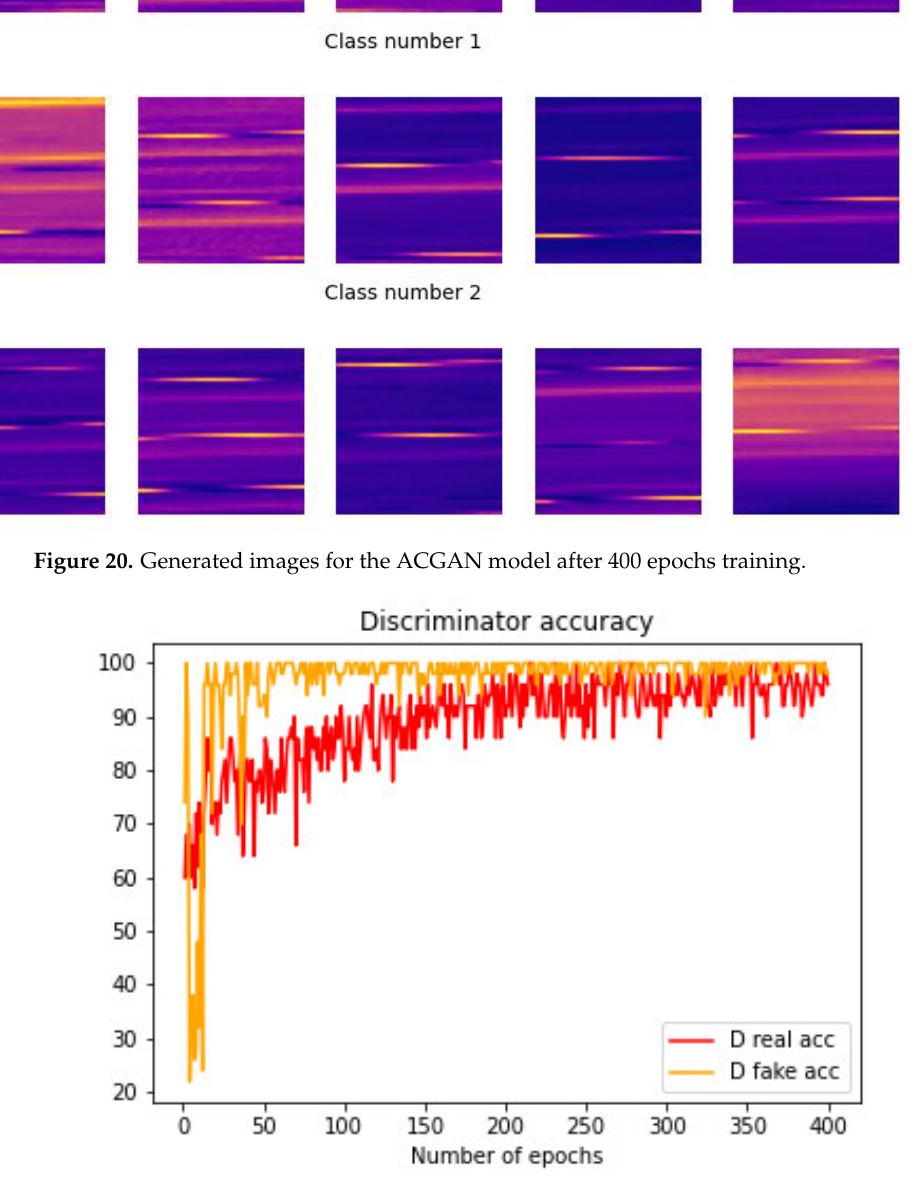
Figure 21. Accuracy of the discriminator for real and synthetic